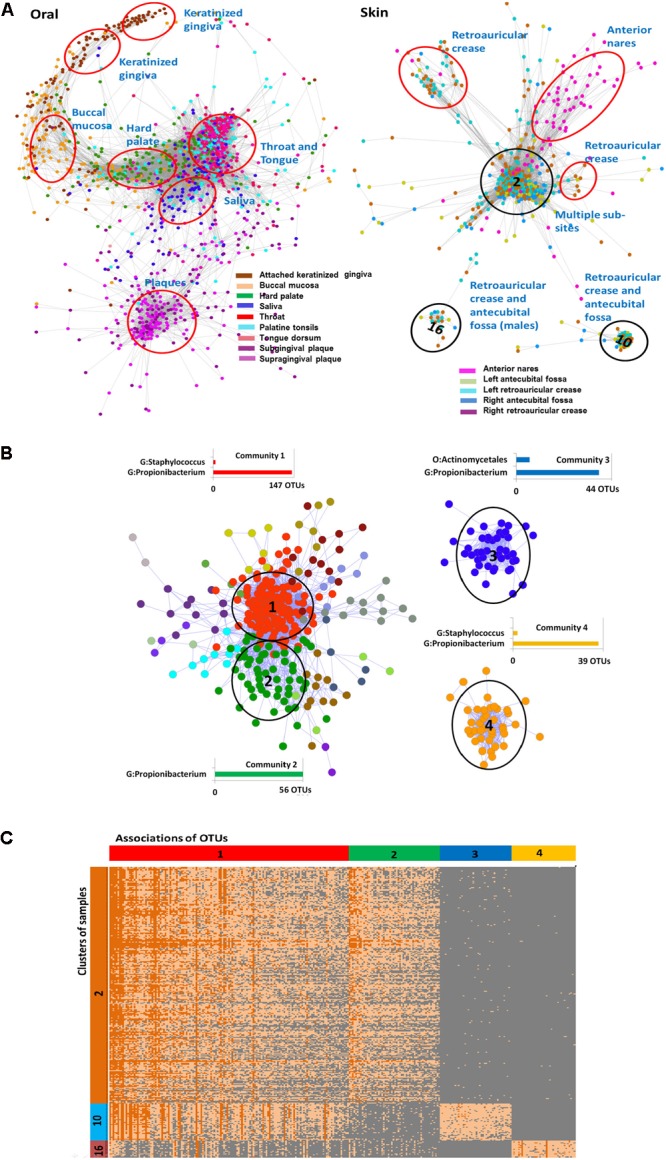
Associations of rare species and samples in the HMP study. (A) Associations of oral and skin samples. Samples in the networks are represented by filled circles colored according to the sampling sub sites in the HMP study. Edges between circles indicate significant association between samples in terms of the shared species richness. Red and black ovals label associations predicted by clustering of the Anets-Samples. Name of each cluster was inferred by the enrichment analysis as described in Section “Materials and Methods.” Black ovals indicate clusters (2, 10, and 16) that were further analyzed by the Anets-OTUs algorithm. (B) Associations of rare species discovered by Anets-OTUs in samples comprised clusters 2, 10, and 16. Small components of the network are not included. OTUs are represented by nodes (filled circles) where color indicates different clusters inferred by Markov clustering. The largest clusters are referred as communities. Edges between nodes represent significant associations (p < 0.001) between a pair of OTUs. They are labeled by black ovals and have associated bar charts showing the number of OTUs from most abundant taxonomic ranks labeled as G (Genus) and O (Order). (C) Heat map of abundances (in terms of sequencing reads) of associating microbial OTUs (horizontal axis) in three distinct clusters of samples (vertical axis) collected from the human skin. OTUs are grouped according to the microbial communities inferred by Anets-OTUs and sorted by mean abundance; samples are grouped according to clusters inferred by Anets-Samples and sorted by the shared richness. Each cell shows the number of OTU reads. Color of cells in the map shows the number of reads representing the OTUs in the sample: 10 reads or more (dark orange), from 1 to 10 reads (light orange), and not represented by reads (gray). Cluster IDs indicated in (A,B) are shown in vertical and horizontal bars of the heat map respectively.